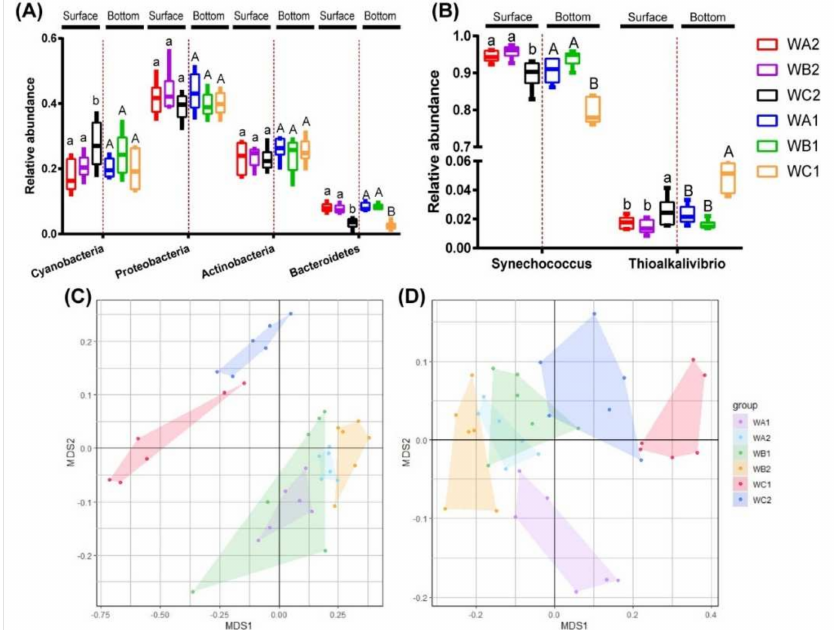
Figure 2. Relative abundance of key taxa and beta diversity of bacterial and carbon-fixation bac- terial community. ( A ) Variation in relative abundance of bacterial phylum (>5%) between areas. ( B ) Variation in relative abundance of carbon-fixation bacterial genus (>1%) between areas. NMDS ordinations based on Bray–Curtis dissimilarity shows the compositions of total 16S rRNA ( C ) and cbbL ( D ) gene